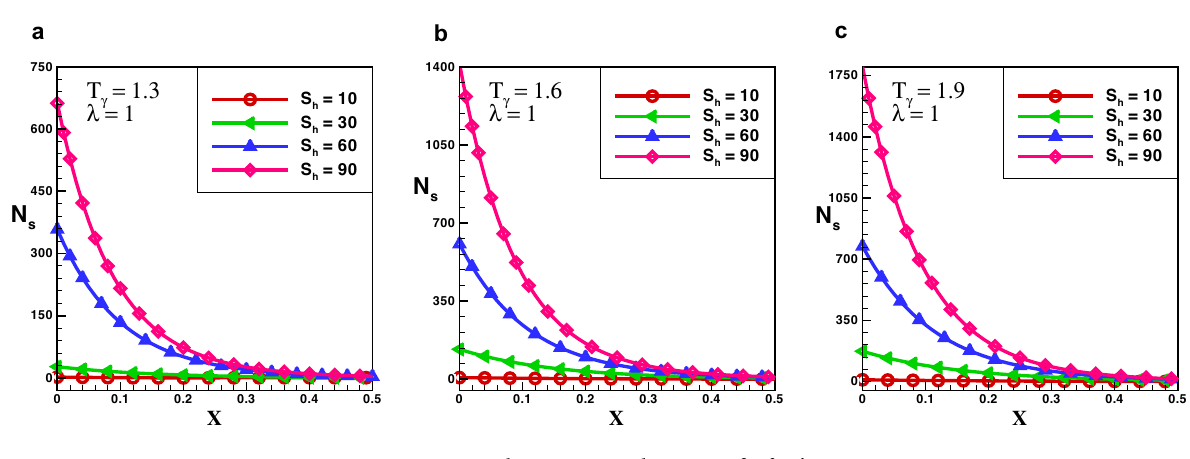
Figure 5. Entropy generation number in rectangular porous fin for (cid:31) = 1